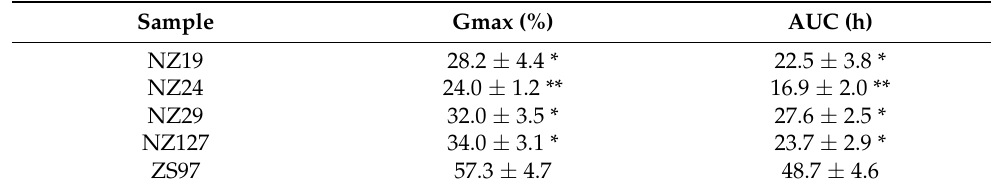
Table 2. Seed storability phenotype shown by Gmax and AUC in four NILs and ZS97. Sample Gmax